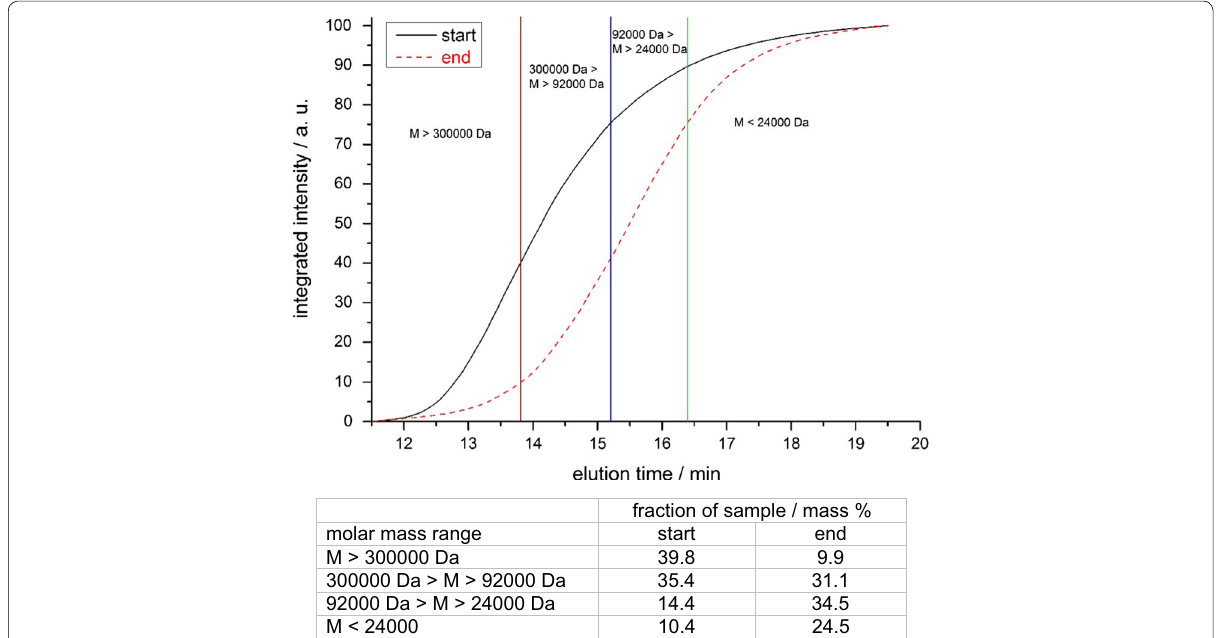
Fig. 3 Molar mass distribution of the lysimeter extract at test start and test end relative to molecular weight reference standards